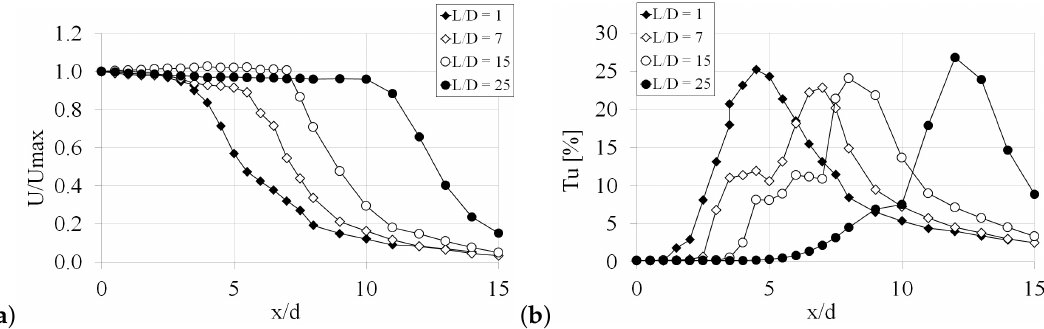
Figure 7. ( a ) Mean and ( b ) fluctuating velocity profiles along the jet axis, S = 0.5, Re =